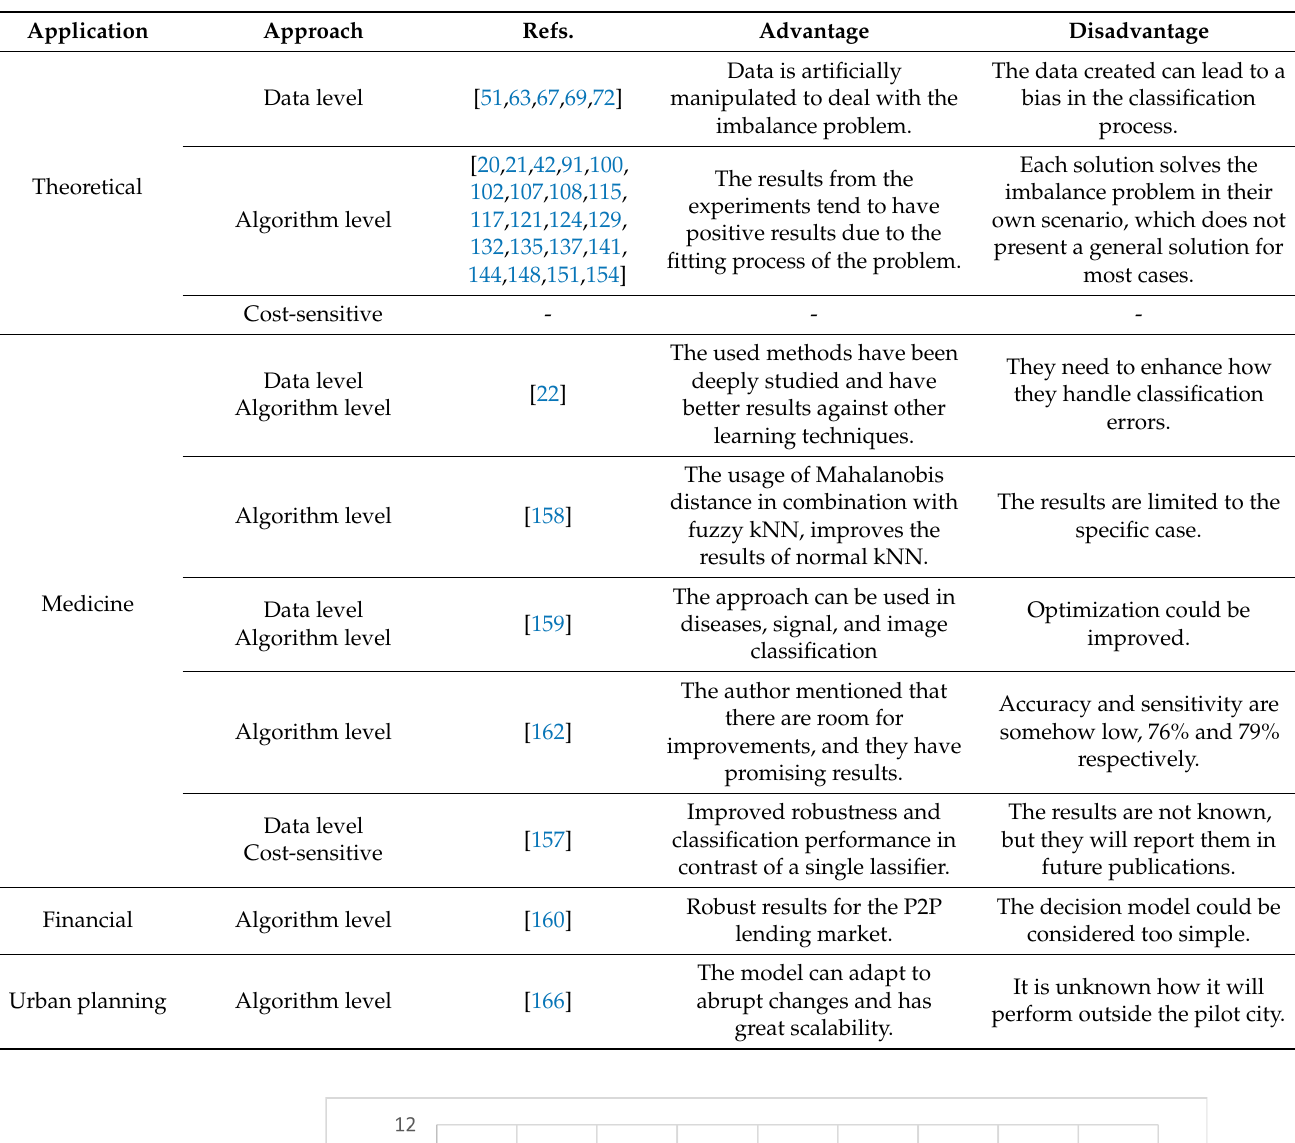
Table 2. Taxonomy of similarities and differences among the reviewed papers.